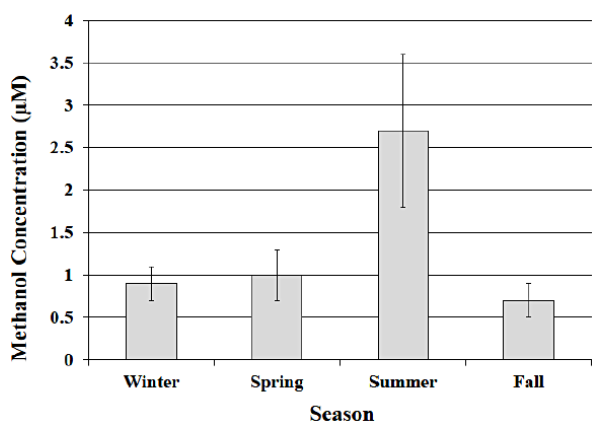
Figure 4. Average volume-weighted methanol concentration plot- ted in each season. Error bars represent ± one standard deviation from the